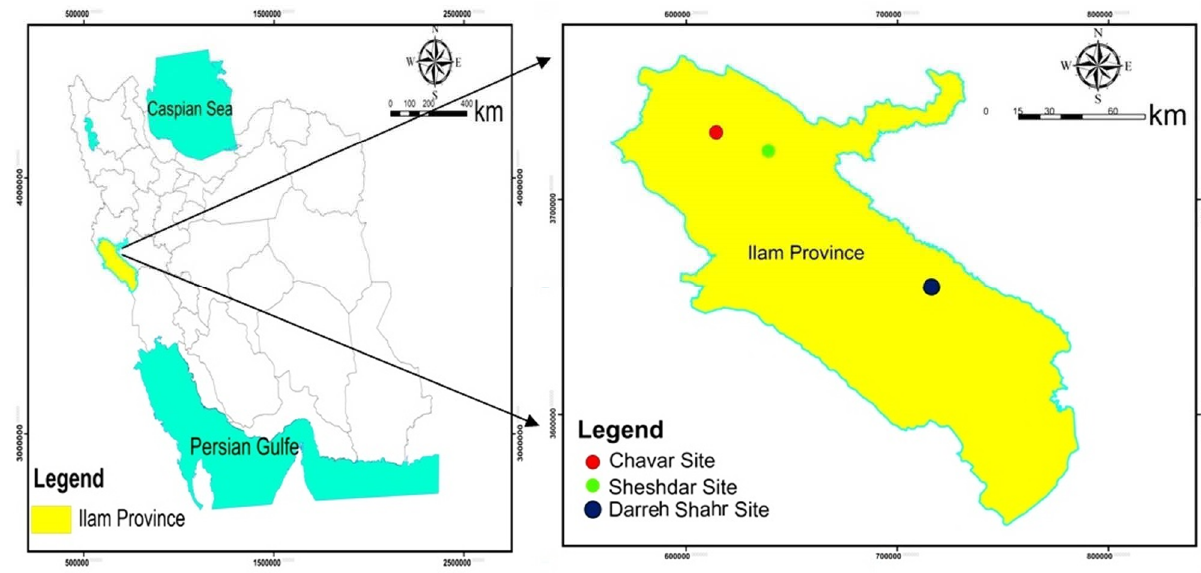
Figure 1. Location of the forest sampled in the Ilam Province in western Iran.